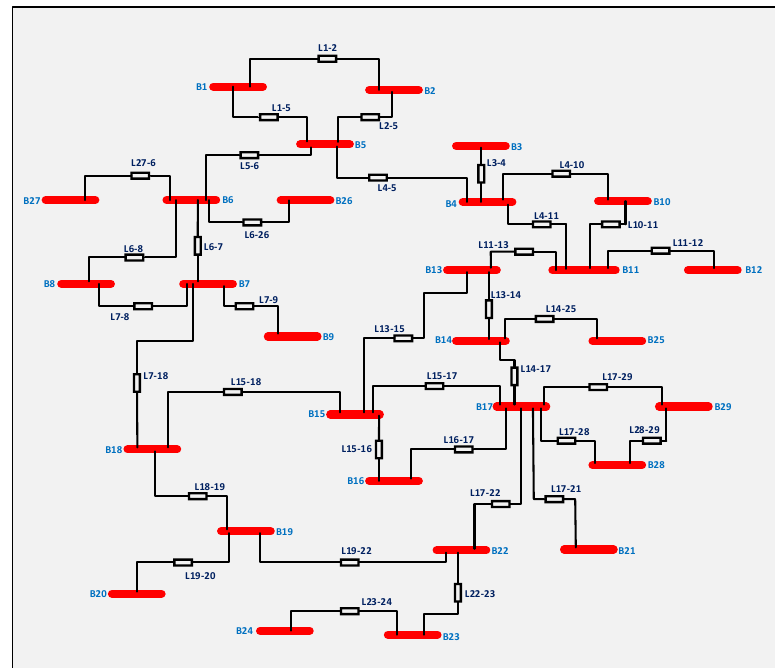
Figure 2. Ecuadorian electrical